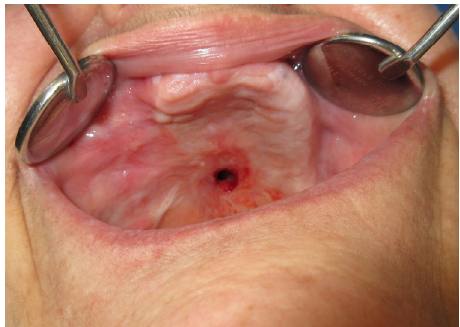
Figure 16. Before NSPF.